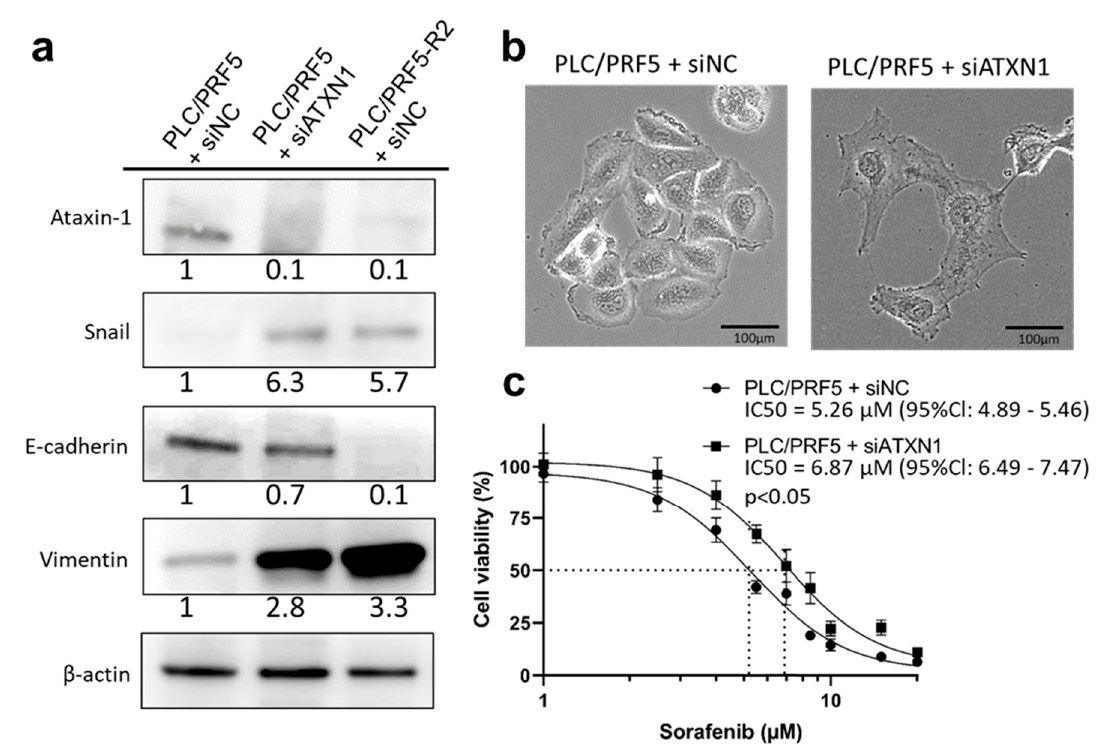
Figure 4. EMT and sorafenib resistance in PLC/PRF5-siATXN1 cells. ( a ) The protein expression of ATXN1 and EMT markers (E-cadherin, Snail, vimentin) in PLC/PRF5-siNC, PLC/PRF5-siATXN1, and PLC/PRF5-R2-siNC cells were examined by western blot analysis. Densitometry analysis indicates relative protein levels from one representative of three independent experiments. Numbers below the bands represent protein expression normalized to β -actin. ( b ) Representative images of PLC/PRF5-siNC and PLC/PRF5-siATXN1 cells under observation with a stereoscopic microscope are shown. Scale bars, 100 μ m. ( c ) The viability of PLC/PRF5-siNC and PLC/PRF5-siATXN1 cells treated with various concentrations of sorafenib was determined by WST assay.